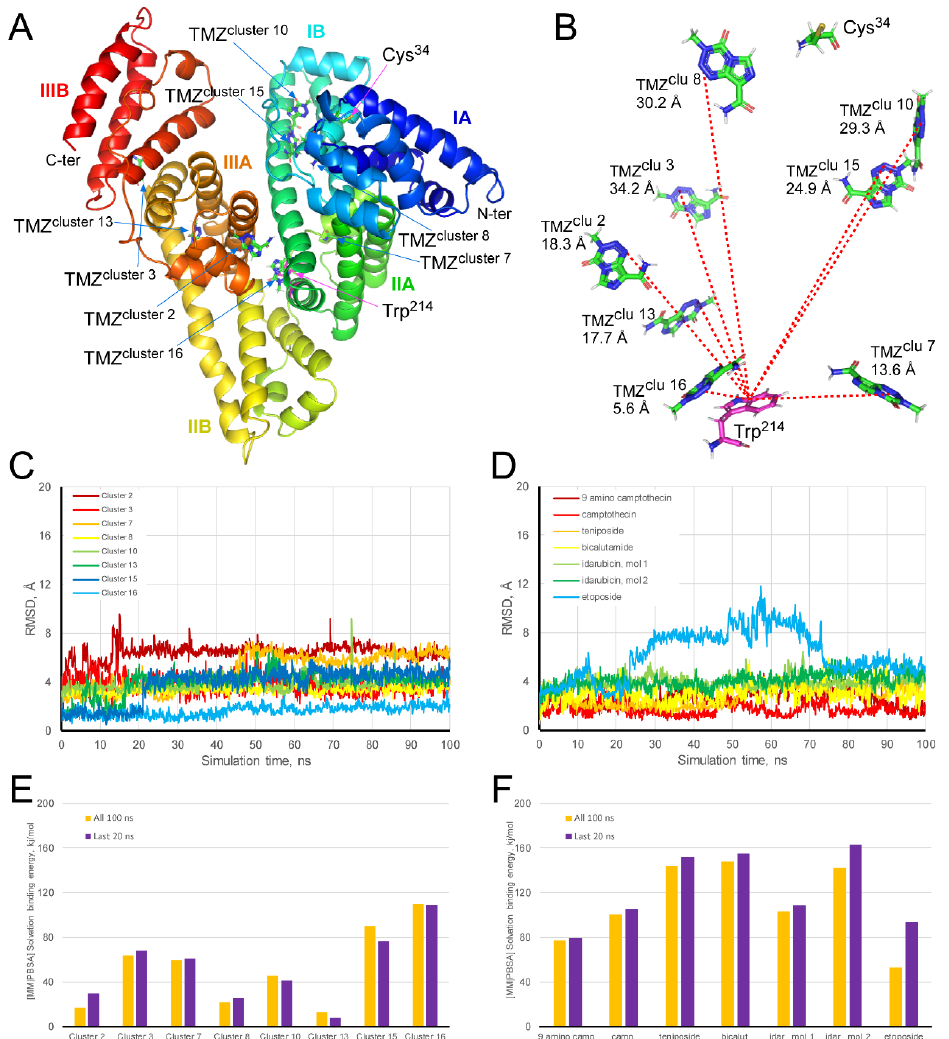
Figure 7. Molecular dynamics simulation of HSA-TMZ complex throughout 100 ns. ( A ) Secondary structure of HSA in rainbow color, from N-terminal (blue) to C-terminal (red). The three subdomains (I, II and III), as well as the amino acids Trp-214 and Cys-34, have been indicated. The docked TMZ molecule with the lowest Gibbs free energy of each cluster has been shown, indicating its location with blue arrows. ( B ) Distance (Å) between Trp-214 and the TMZ molecules of each cluster. ( C , D ) The trajectory (RMSD, Å) of TMZ molecules docked to HSA and different antineoplastic drugs bound to HSA, respectively. Molecular mechanics/Poisson–Boltzmann surface area solvation binding energy analysis of the HSA forming a complex with TMZ ( E ) and some antineoplastic ( F ), using YASARA dynamics v19.9.17 software. The best-docked complex, as the initial conformation for MD simulation, followed by 1000 snapshots (100 ns) obtained from the MD trajectory, were employed to calculate the values of solvation binding energy of TMZ or antineoplastic drugs. Additionally, the average value calculated for the last 200 snapshots (20 ns) is also displayed. YASARA-calculated binding energy provides positive values when the predicted binding is strong and stable whereas, negative values indicate no binding. Figures 7A,B were prepared using PyMol 2.3 software.